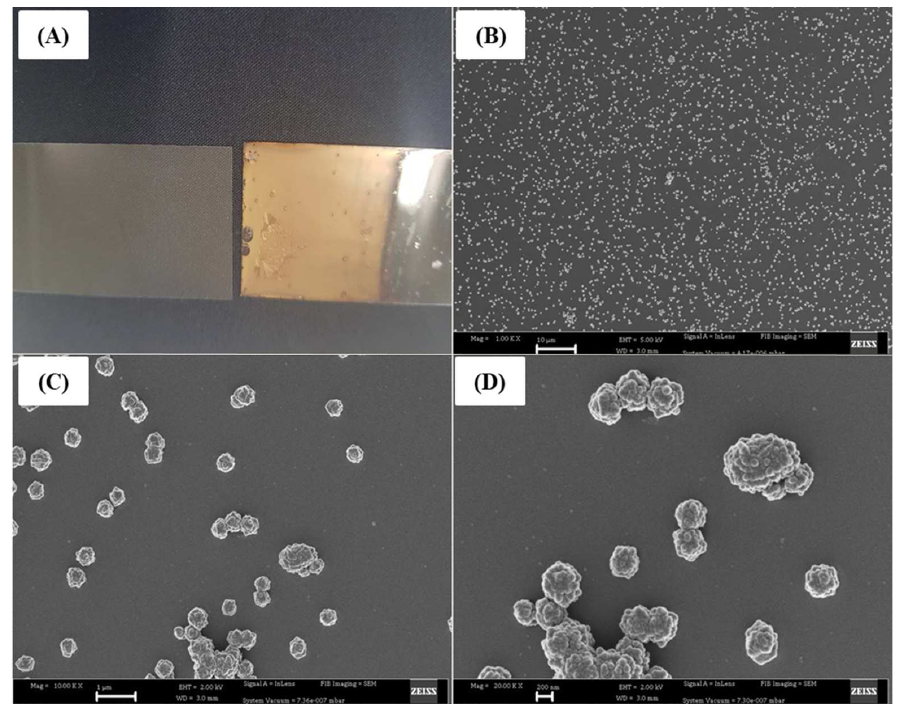
Figure 1. Images of a gold-coated slide after self-assembly. ( A ) Visual image of plain and coated slides. ( B – D ) SEM images of gold nanoparticles at 1, 10 and 20 × magnification, respectively, acquired from a Zeiss scanning electron microscope.